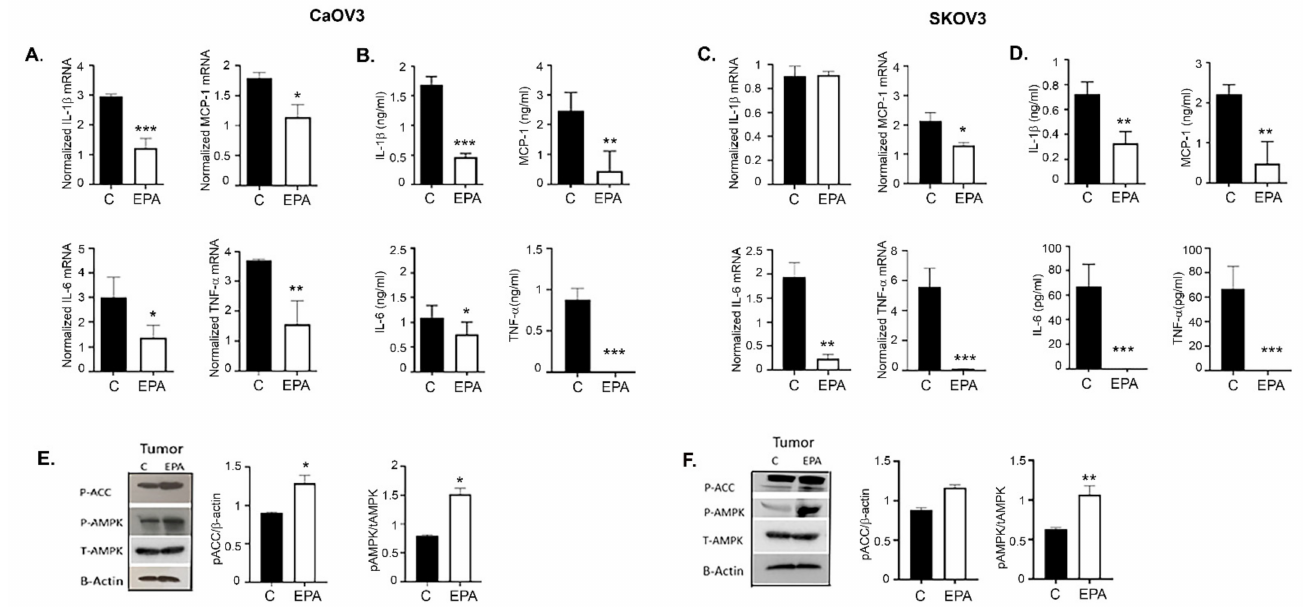
Figure 9. EPA lowers the inflammatory milieu in ovarian tumors and its microenvironment. Pooled mRNA from tumor tissues ( n = 3) was assayed for inflammatory of interleukin (IL)-1 β , MCP-1, IL-6, and TNF- α in ( A ) CaOV3 and ( C ) SKOV3ip mice treated with EPA or vehicle. Protein levels of IL-1 β , MCP-1, IL-6, and TNF- α in plasma ( n = 3) isolated from ( B ) CaOV3 and ( D ) SKOV3ip mice treated with EPA or vehicle. ( E , F ) Representative immunoblots showing phosphorylated (p)-ACC, AMPK and total (T) AMPK and β -actin expression from pooled tumors ( n = 3) from vehicle (C) or EPA treated mice. Bar plots show normalized densitometric analysis from two individual blots. Uncropped Western blot images are shown in Figure S9. * p ≤ 0.05, ** p ≤ 0.01, and *** p ≤